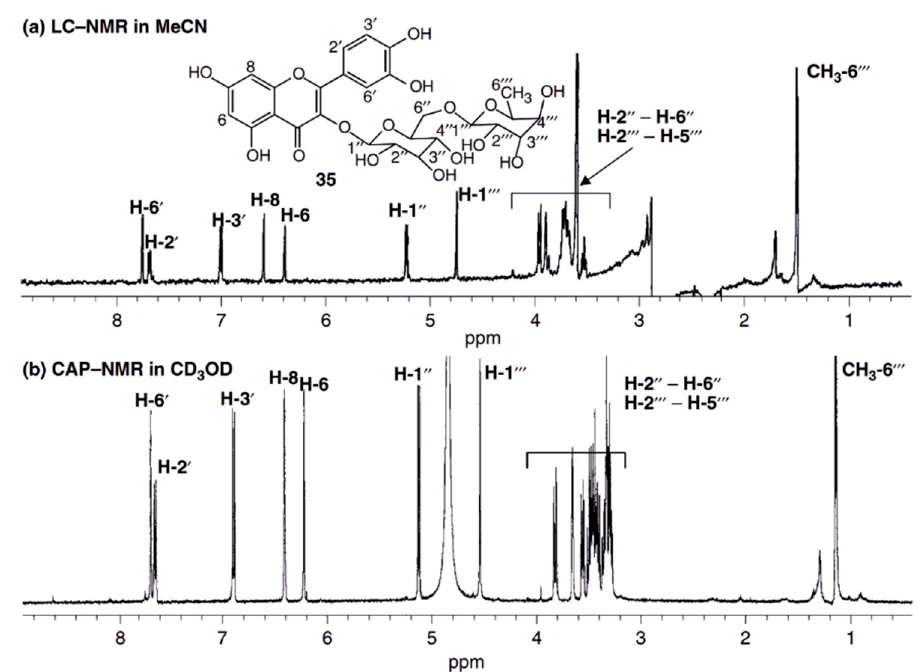
Figure 2. Comparison of the 1H NMR spectra of 20 µg rutin recorded by the stopped flow HPLC- NMR ( a ) and by capNMR ( b ). Both spectra were recorded on a 500 MHz spectrometer. Due to the higher sensitivity of the capNMR probe-head, the acquisition of the capNMR spectrum took only 10% of the HPLC-NMR measurement time. The S/N ratio of the capNMR spectrum is better than in HPLC-NMR and utilizing a deuterated NMR solvent (methanol-d 4 ), lead to an undisturbed baseline since no experimental suppression of the solvent signal had to be performed. Reprint from Wolfender et al. [73] with permission from Wiley.